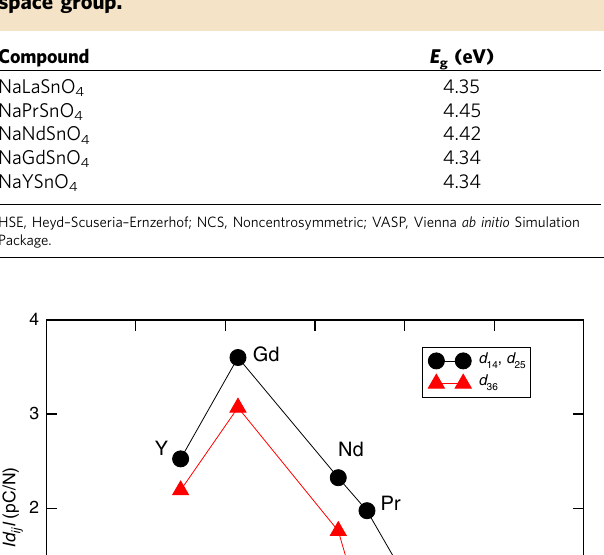
Table 5 | Bandgap ( E g in eV) at the HSEsol level for each Na R SnO 4 compound from VASP 69,70 in the NCS P (cid:2) 42 1 m space group.